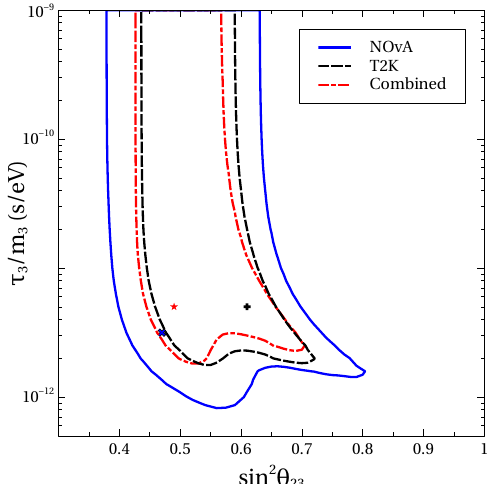
Figure 4 . Muon event spectra for NOvA and T2K. The left panel is for NOvA while the right panel is for T2K. The black dots with the error-bar are actual data points. The error bars correspond to the 1 (cid:27) statistical error.